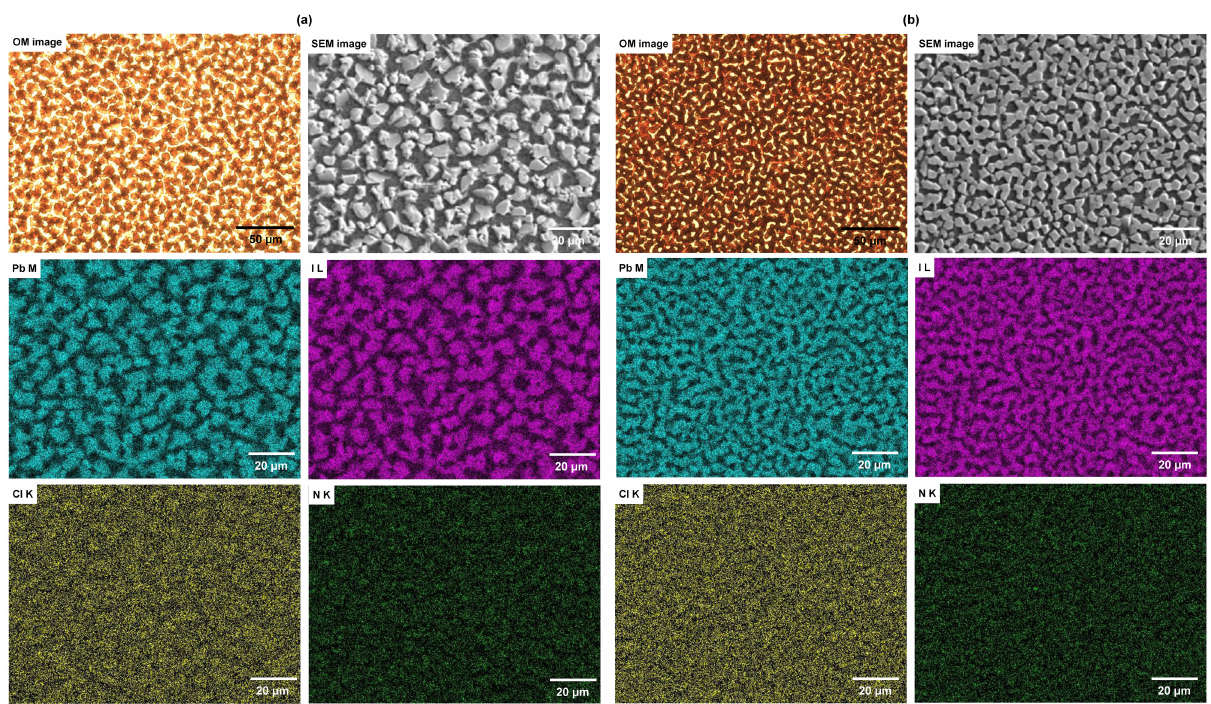
Figure 40: (a) Optical microscope images, SEM images and corresponding elemental mapping images of the CH 3 NH 3 PbI 3 (Cl) cell (a) without NH 4 Cl and containing 5 mg of NH 4